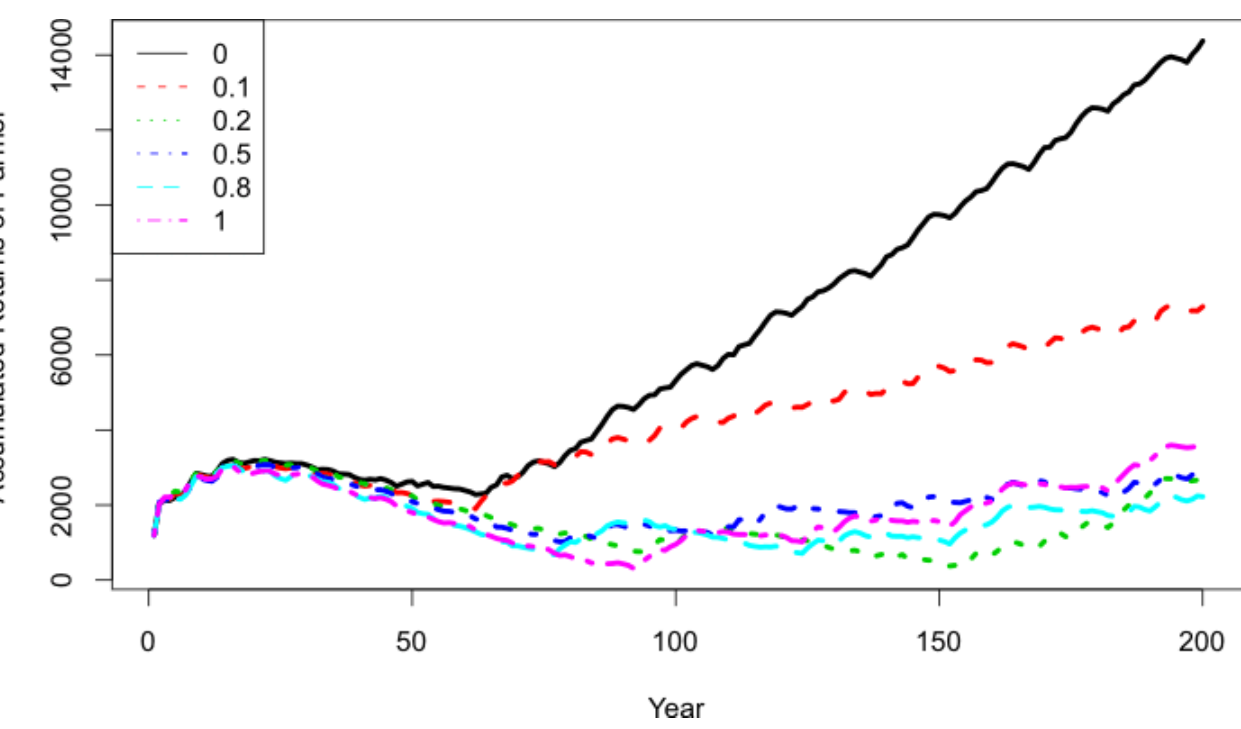
Fig. 10. Individual returns over time of farmer 9 for delta 0, 0.1, 0.2, ...., 1. Parameter values are the same as in Fig. 6, except for target catch level